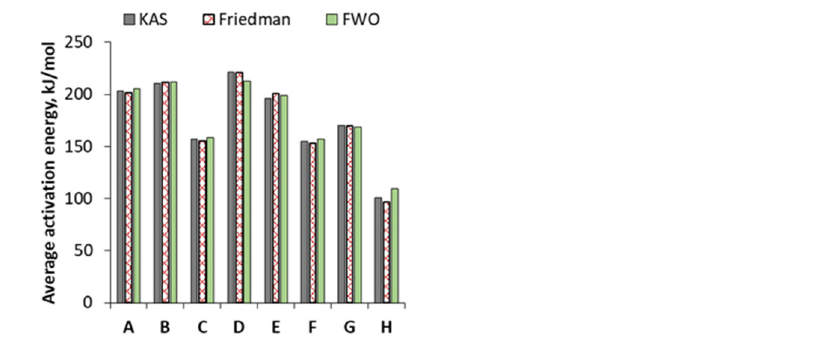
Figure 7. Activation energies calculated by the KAS, Friedman and FWO methods.